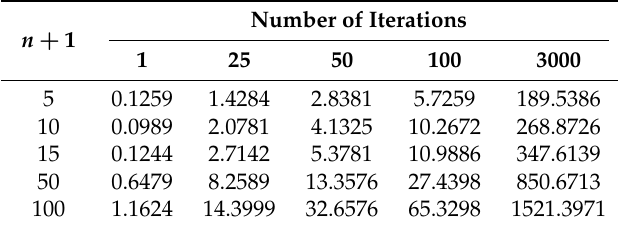
Table 2. Time of execution of the proposed algorithm measured in seconds for different numbers of units and iterations. The values provided are the mean of 5 repetitions with a set of data points of size 100. n +